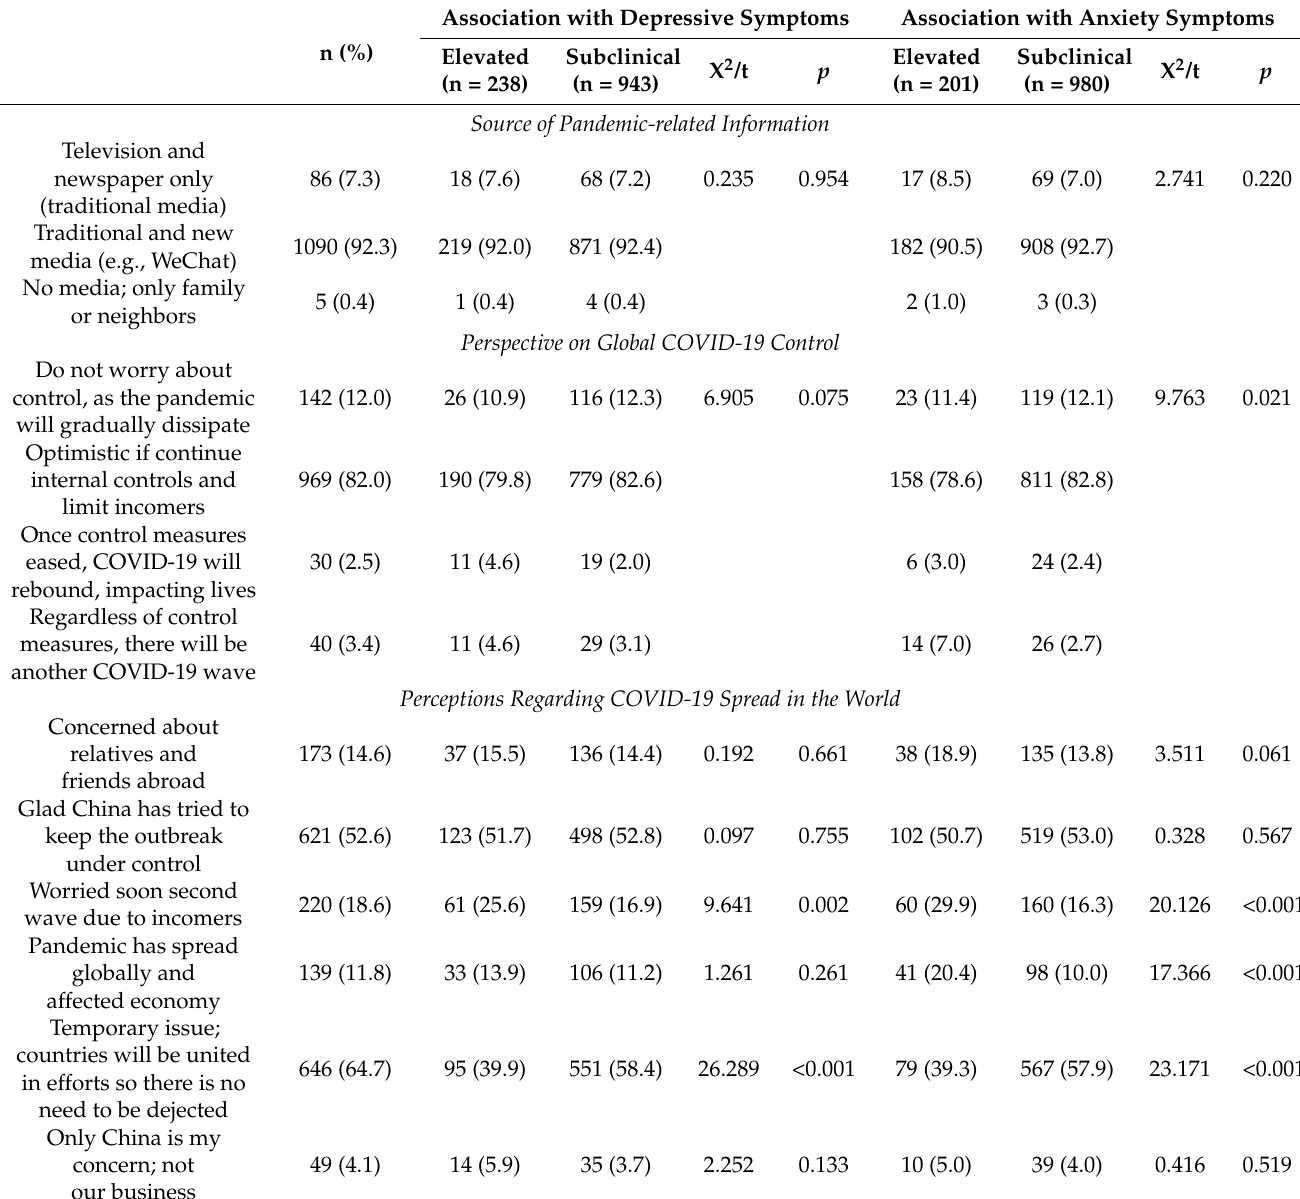
Table 3. Pandemic Attitudes and Health Impact and their Associations with Depressive and Anxious Symptoms, N = 1181. Association with Depressive Symptoms Association with Anxiety Symptoms n (%) Elevated